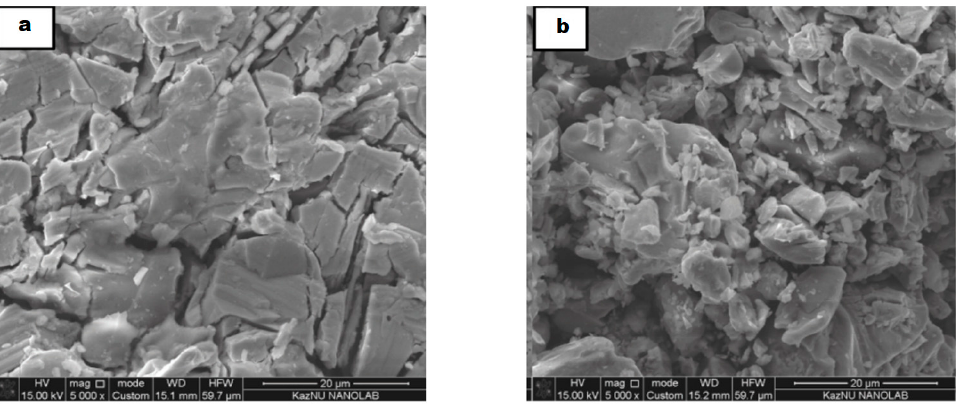
Figure 2. Electron microscopic images ( × 5000) of a Ni-skeletal catalyst: ( a )—without ultrasonic exposure; ( b )—with ultrasonic exposure [67].